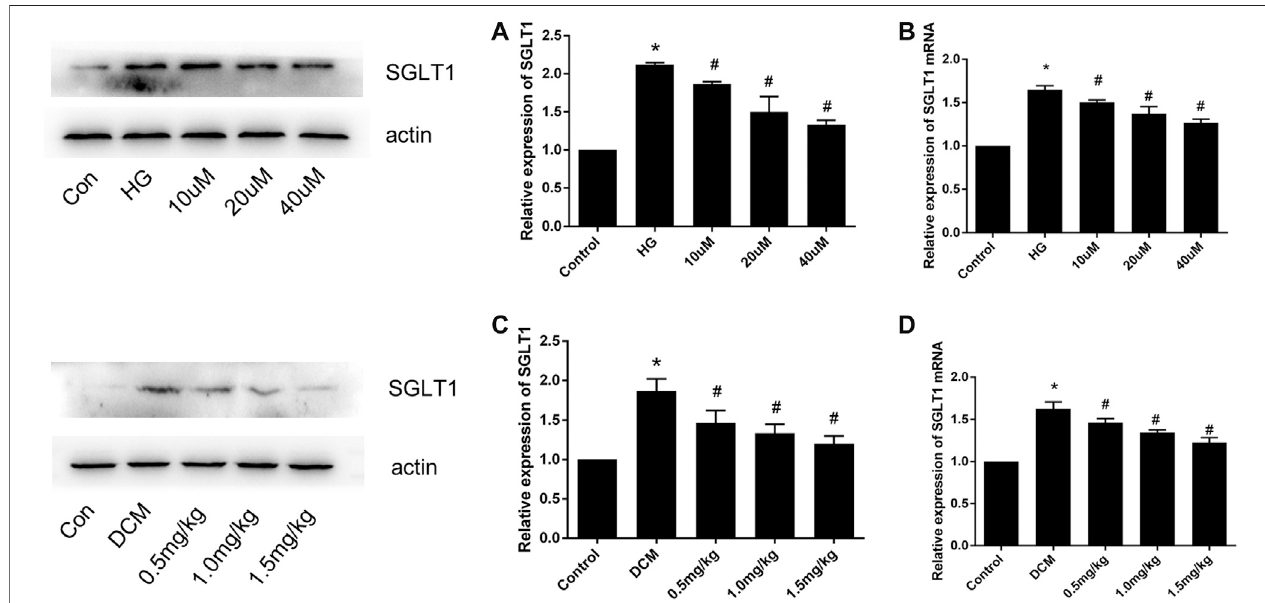
FIGURE5| SGLT1expressioninH9C2cellsanddiabeticrats(n (cid:1) 10). (A) Westernblotand (B) RT-PCRanalysesofSGLT1proteininH9C2cells. (C) Westernblot and (D) RT-PCR analyses of SGLT1 in tissues. * p < 0.05 compared with the control group; # p < 0.05 compared with the DCM group. Experiments were performed in